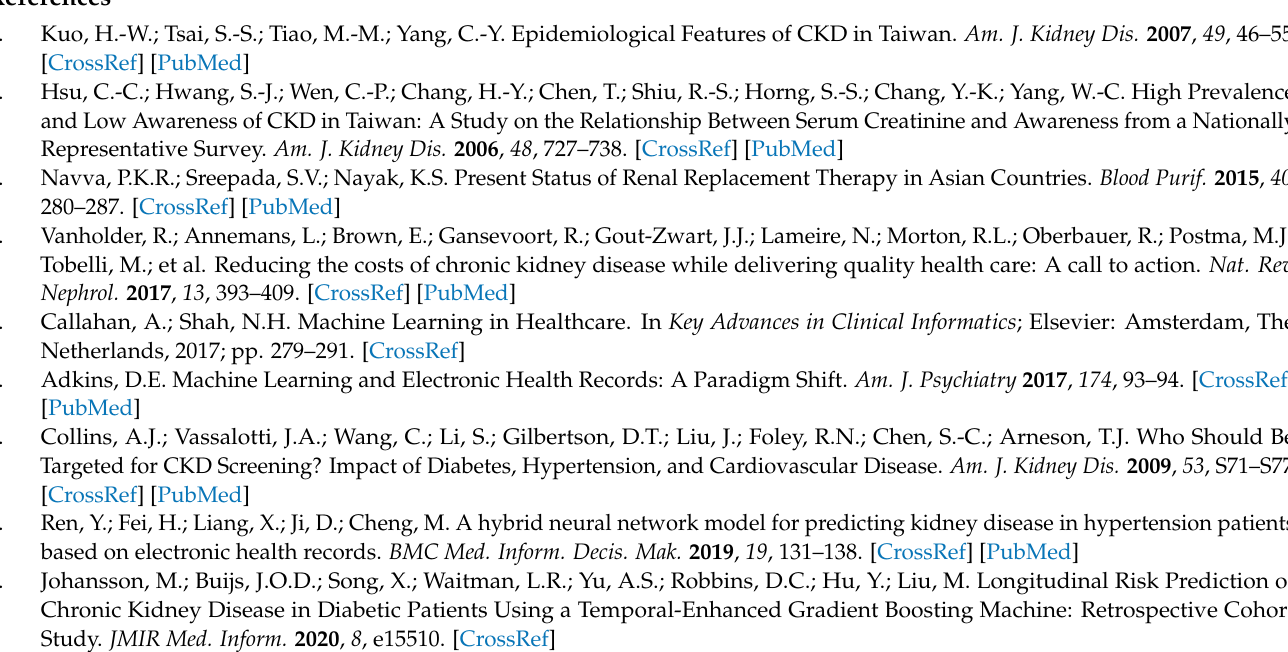
Figure S2 The correlation plot for the CKD patients; Figure S3 The correlation plot for the non-CKD people; Figure S4: Number of months visited by the CKD patients for diagnosis/drugs during the observation period (24 months) as a histogram; Figure S5: Number of months visited by the non-CKD patients for diagnosis/drugs during the observation period (24 months) as a histogram; Table S1. Hyperparameter values of the tested models. Models with the prefix “temp” using the temporal quarterly data; Table S2. The threshold values used for each model to compute the performance